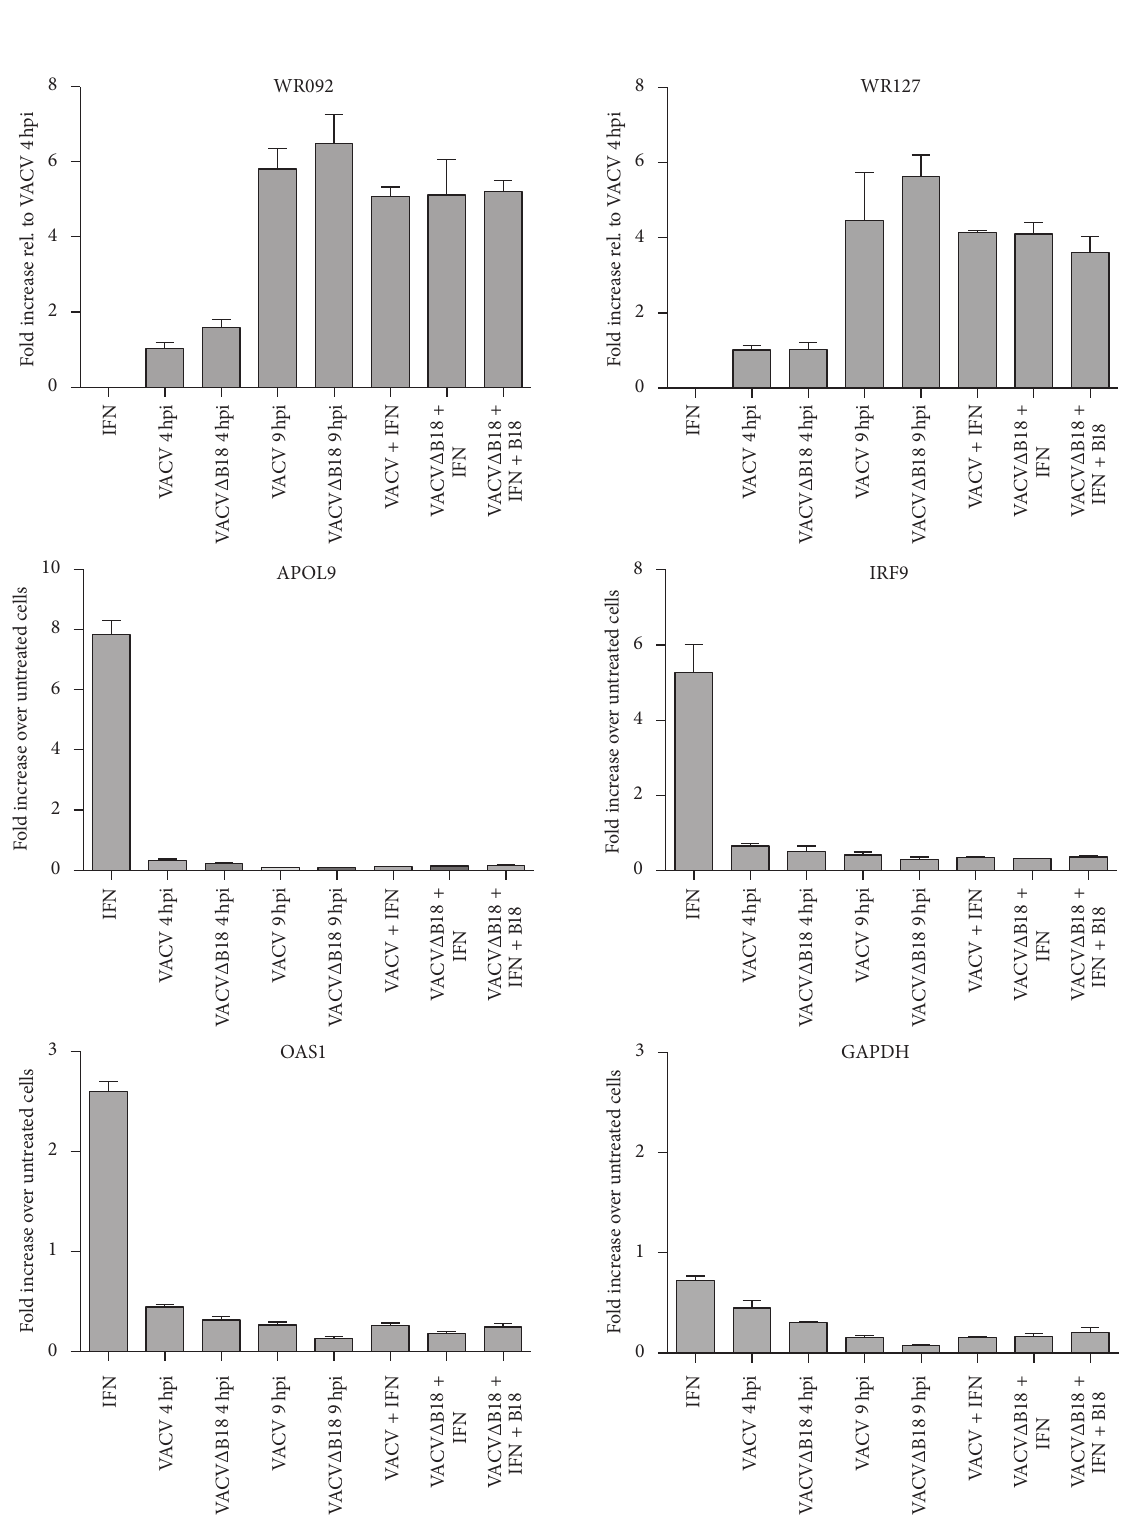
Figure 6: Confirmation of RNA-seq data by RT-qPCR during VACV infection. Gene expression for the indicated genes was assessed by RT- qPCR from VACV- or VACV Δ B18-infected L929 cells at 4 hpi and 9hpi. IFN was added to infected cells at 5 hpi where indicated. Expression levels of WR092 and WR127 VACV genes were also determined to monitor the progress of infection and relativized to VACV 4hpi expression values. Mean from 3 biological replicates ± SEM and significant differences are